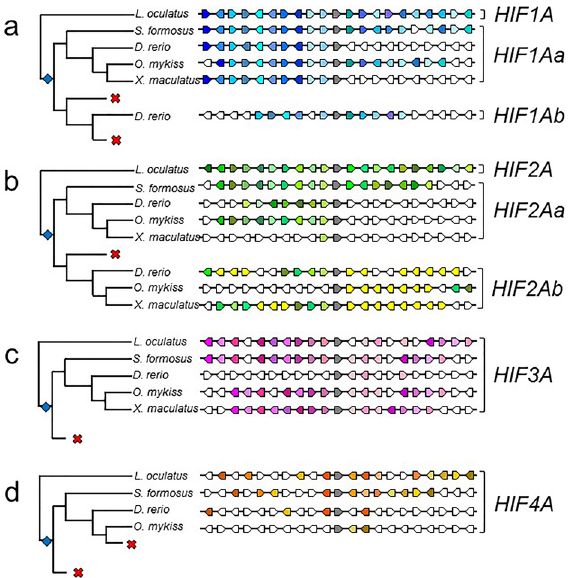
Figure 2. Synteny analysis of actinopterygian ( a ) HIF1A , ( b ) HIF2A , ( c ) HIF3A , and ( d ) HIF4A . The 10 flanking genes on either side of each HIFA paralog (gray arrows) are compared among spotted gar ( Lepisosteus oculatus ), Asian arowana ( Scleropages formosus ), zebrafish ( Danio rerio ), rainbow trout ( Onchorhynchus mykiss ), and southern platyfish ( Xiphophorus maculatus ). For each HIFA paralog, genes shared between spotted gar and more derived fishes are uniquely colored (see gene abbreviations in Supplemental Table S2). For HIF2A , genes shared among HIF2Ab but not present in HIF2Aa are shown in yellow. The relationships among fishes is from Hughes et al. 37 and branch lengths do not indicate divergence times. The teleost-specific genome duplication is indicated by the blue diamonds, and putative losses of specific HIFA paralogs are shown by reds